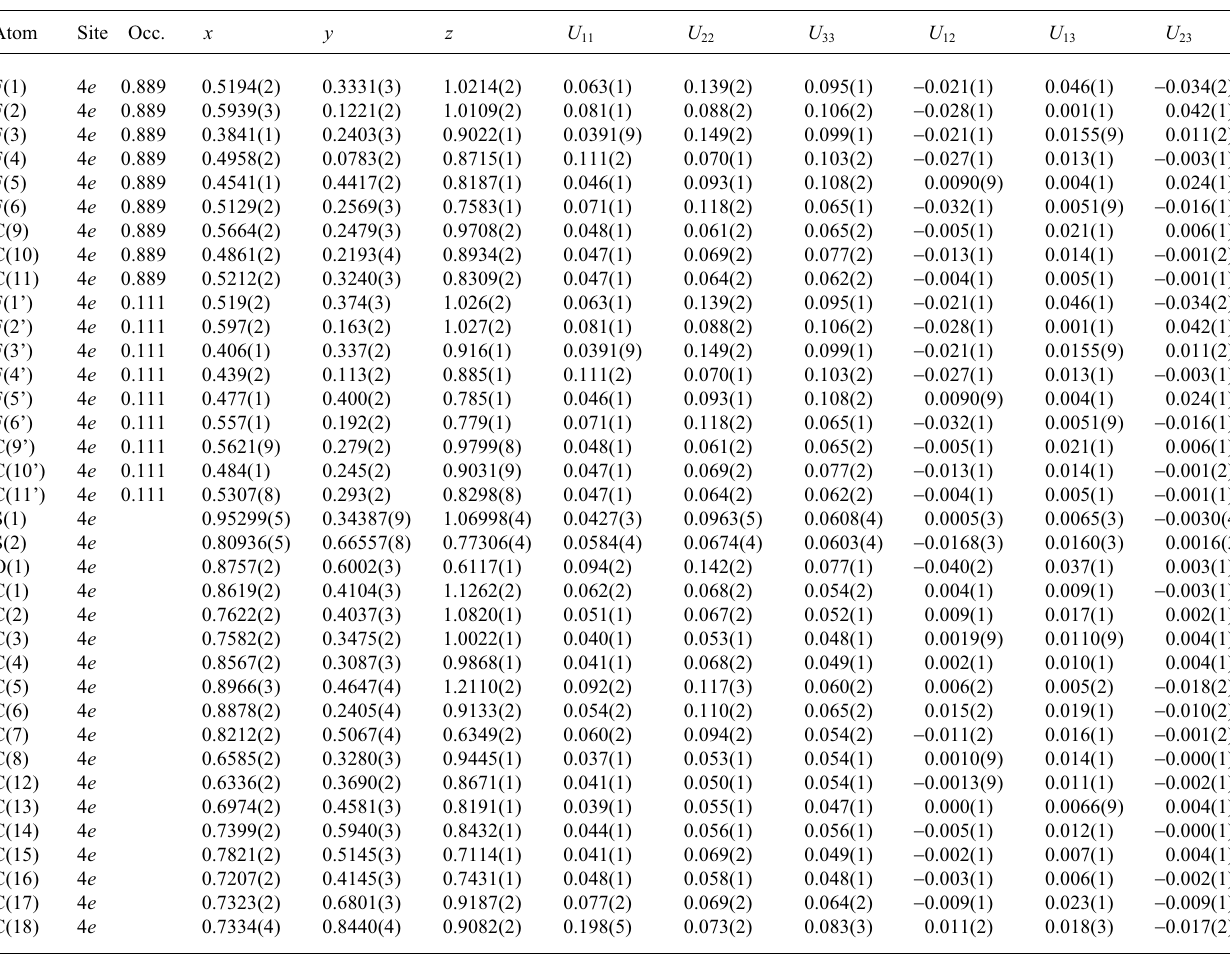
Table 3. Atomic coordinates and displacement parameters (in Å 2 ) . Atom Site